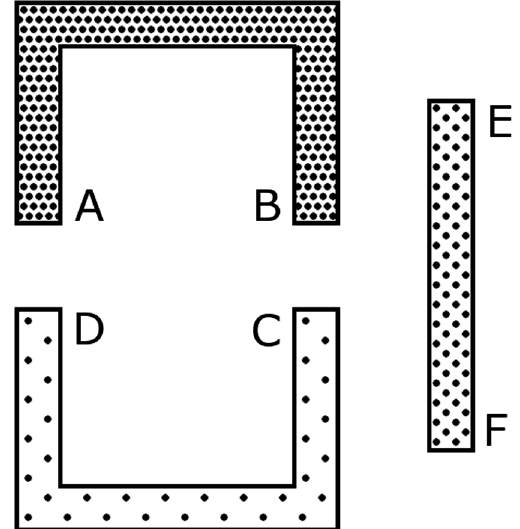
FIG. 2. A simple diagram visualizes the qualitative relationship between air pressure difference, resistance, and air flow.